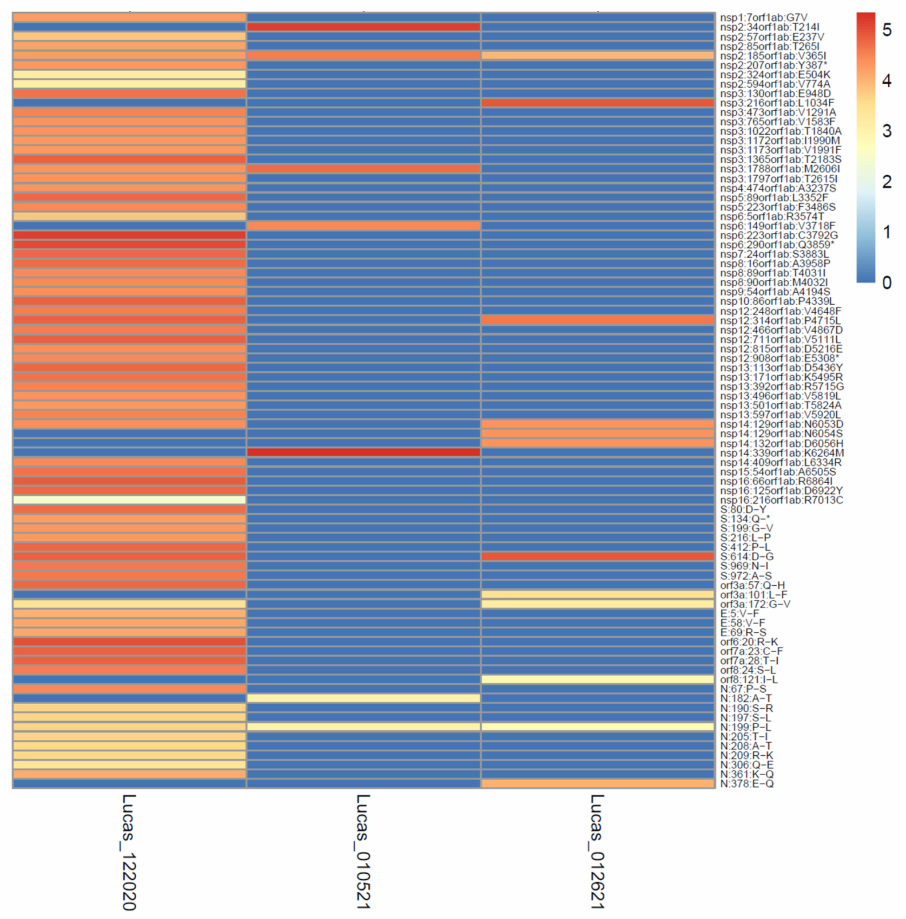
Figure 8. High depth of coverage across the genome increases the sensitivity of mutation detection. The data from three samples from Lucas collected in the winter of 2020–2021 varied according to depth of coverage (the colors of the cells depict the logarithm of the number of reads covering each mutation site) and mutations detected (mutation sites shown on the y